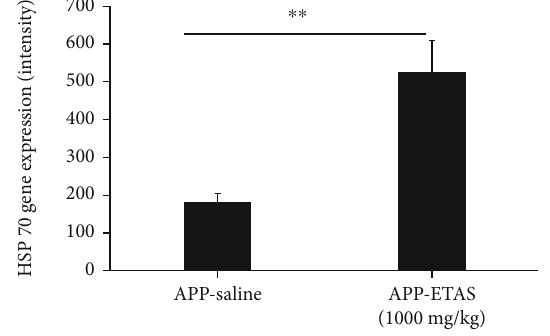
Figure 4: Representation of heat shock protein 70 (HSP70) gene expression (intensity units) in APP mice treated with ETAS (1000mg/kg) vs. APP saline-treated mice. ∗∗ p < 0 : 01 APP+ETAS (1000mg/kg) vs. APP saline-treated mice. Samples were run in duplicate; N = 10 mice in each group.